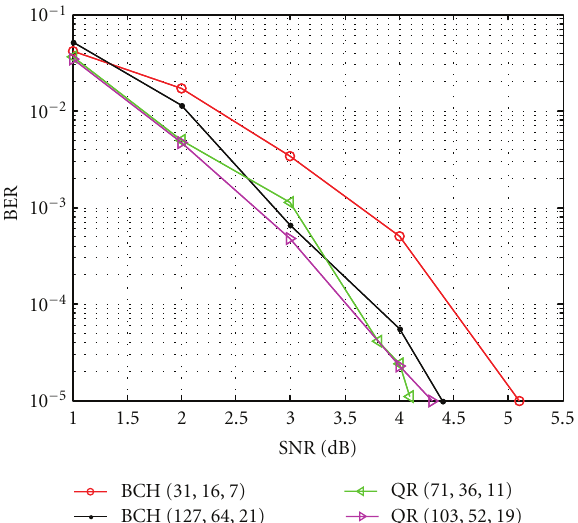
Figure 8: E ff ect of mutation rate on performances.